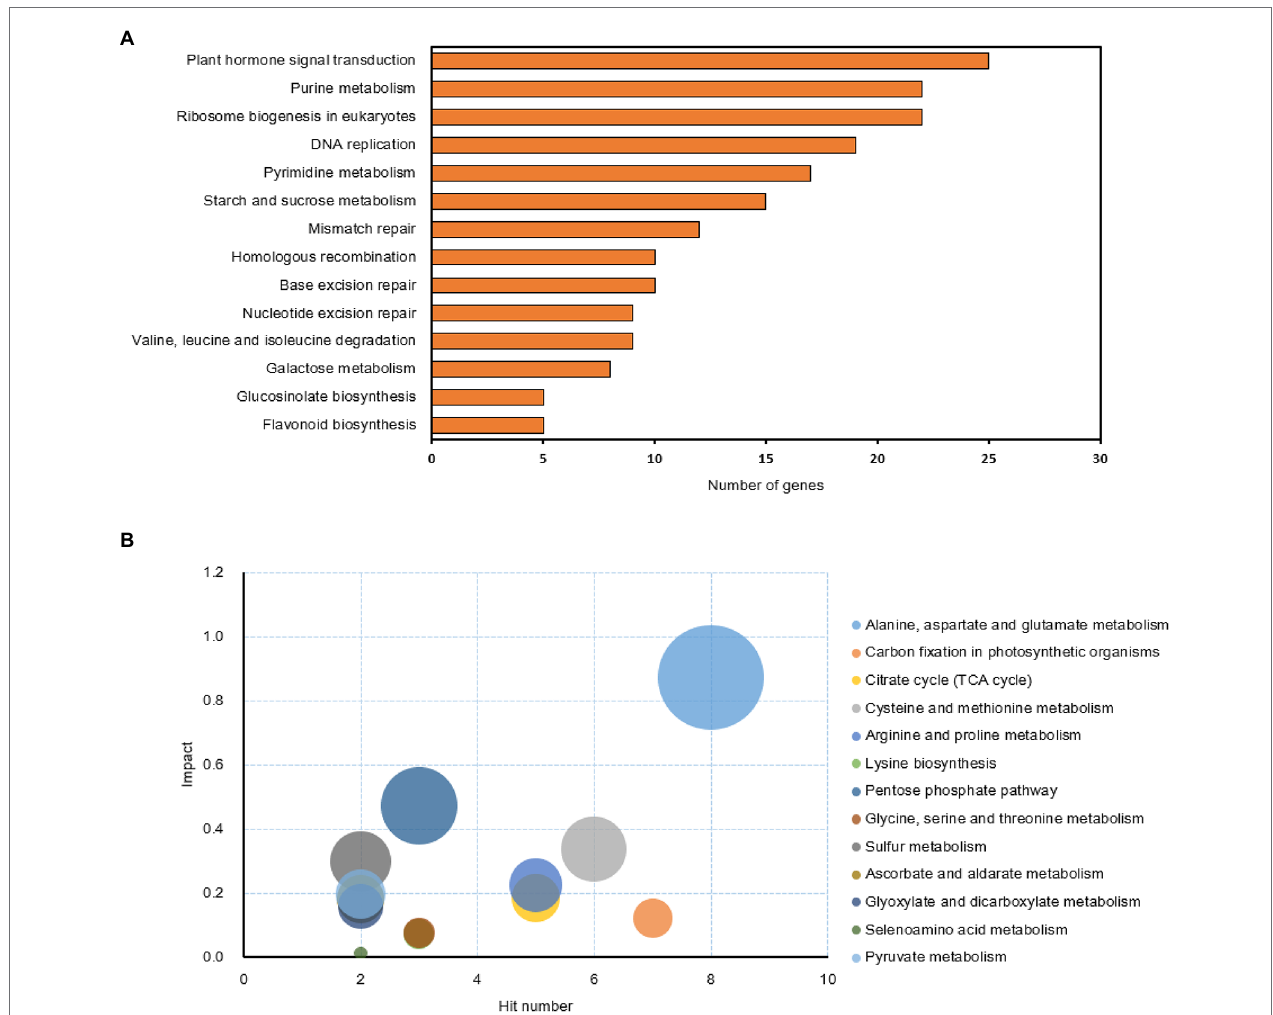
FIGURE 1 | KEGG analysis of the genes and compounds involved in the antagonistic effect of sucrose and auxin in buds treated for 24 h. (A) KEGG pathway analysis of the antagonistic-related genes ( p < 0.05) based on ClusterProfiler analysis (Yu et al., 2012); (B) KEGG pathway analysis of the compounds ( p < 0.05) influenced by the antagonistic effect of sucrose and auxin based on MetaboAnalyst database analysis (Chong and Xia,